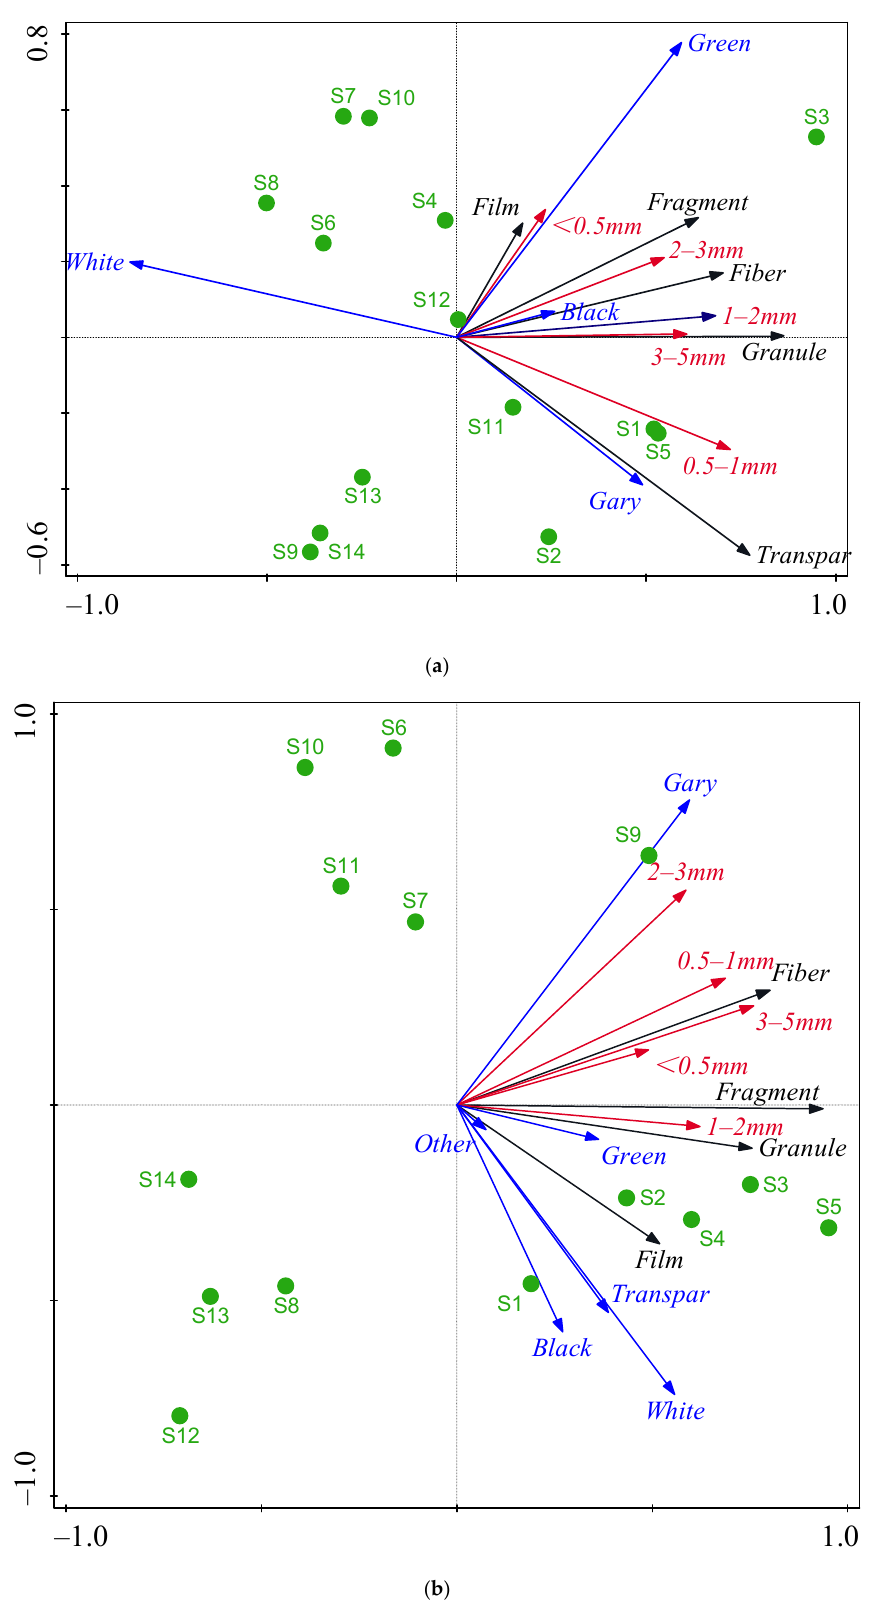
Figure 6. Principal component analysis (PCA) plot for MPs: ( a –Rain season, b –Dry